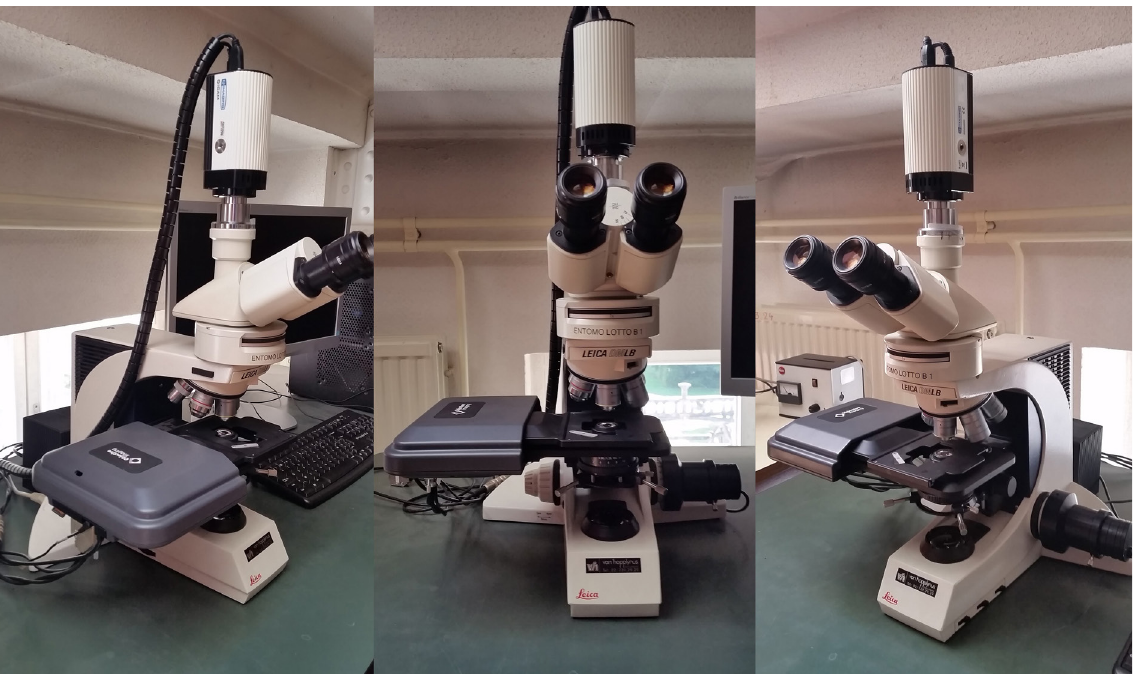
Fig. 2.12. General view of the ‘Information in Images’ system mounted on a Leica microscope at the Royal Museum for Central